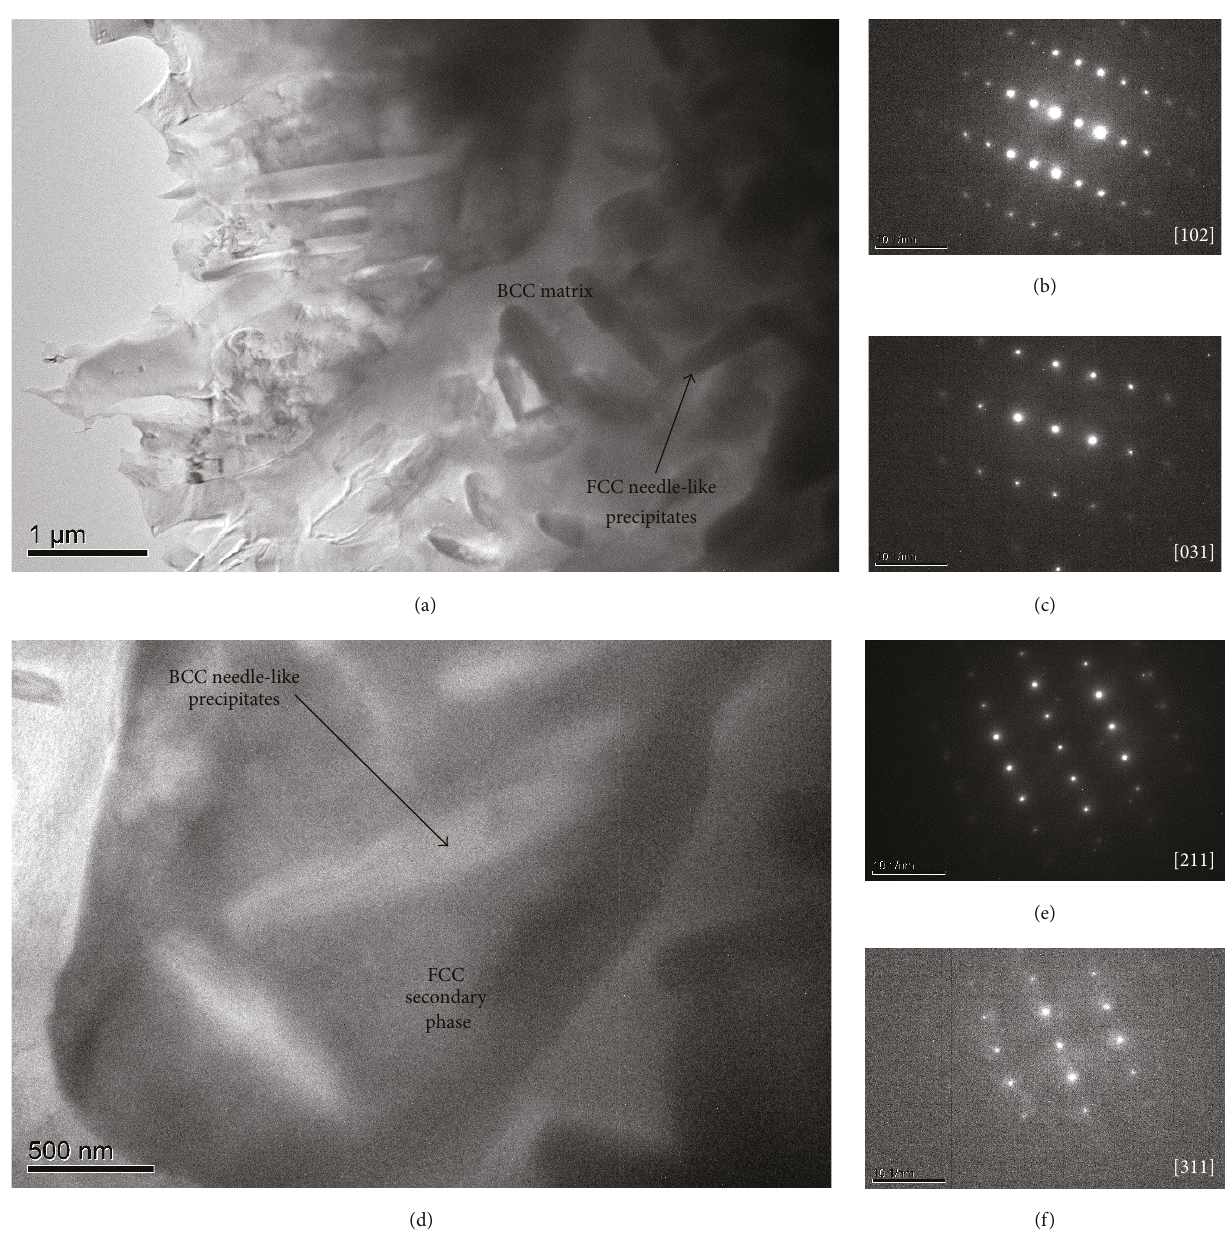
Figure 5: TEM image and corresponding SAED patterns of bulk AlCoCuFeMnNi HEA after heat treatment. (a) Bright field image showing the primary and secondary phases. (b) SAED pattern of the matrix from [102] BCC zone axis; (c) SAED pattern of FCC needle-like precipitates from [031] FCC zone axis; (d) bright field image showing the second phase and needle-like precipitates within; (e) SAED pattern of the second phase particle from [211] FCC zone axis; (f) SAED pattern of the needle-like precipitates within secondary phase from [311] BCC zone